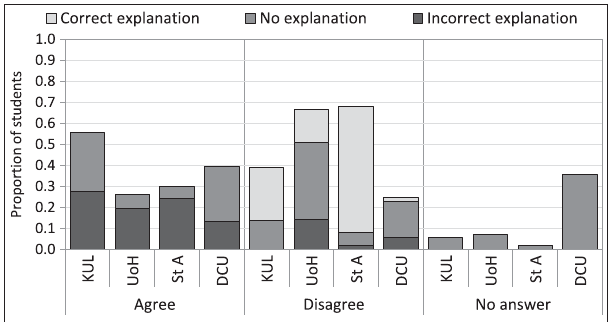
FIG. 10. Distribution of responses and corresponding argumentation to question 4(d) [Fig.